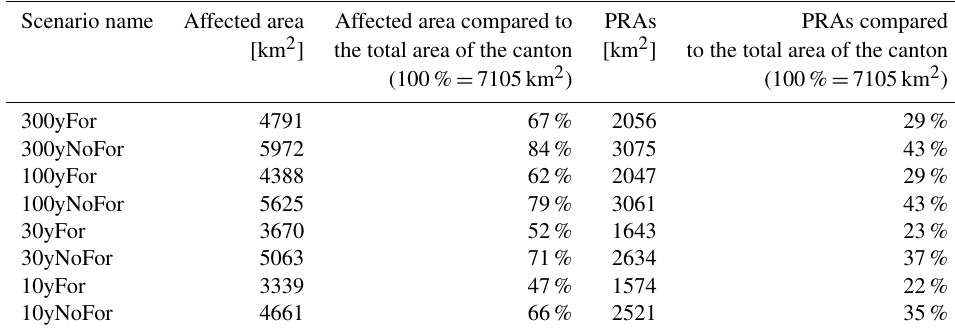
Table 2. Statistical overview of the simulation results for the eight different scenarios over the entire canton of Grisons. Scenario name Affected area Affected area compared to PRAs PRAs compared [km 2 ] the total area of the canton [km 2 ] to the total area of the canton (100% = 7105km 2 ) (100% = 7105km 2 ) 300yFor 4791 300yNoFor 5972 100yFor 4388 100yNoFor 5625 30yFor 1643 30yNoFor 10yFor